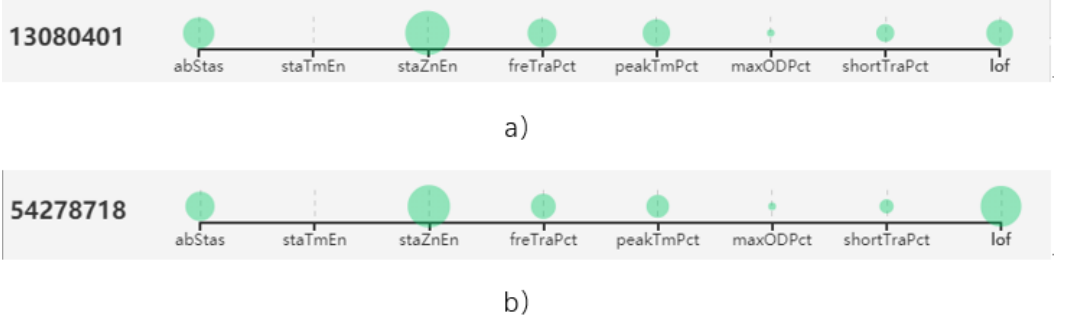
Figure 15. Travel feature values of card numbers 13080401 and 54287878 ( a ) Card number 13080401, ( b ) Card number